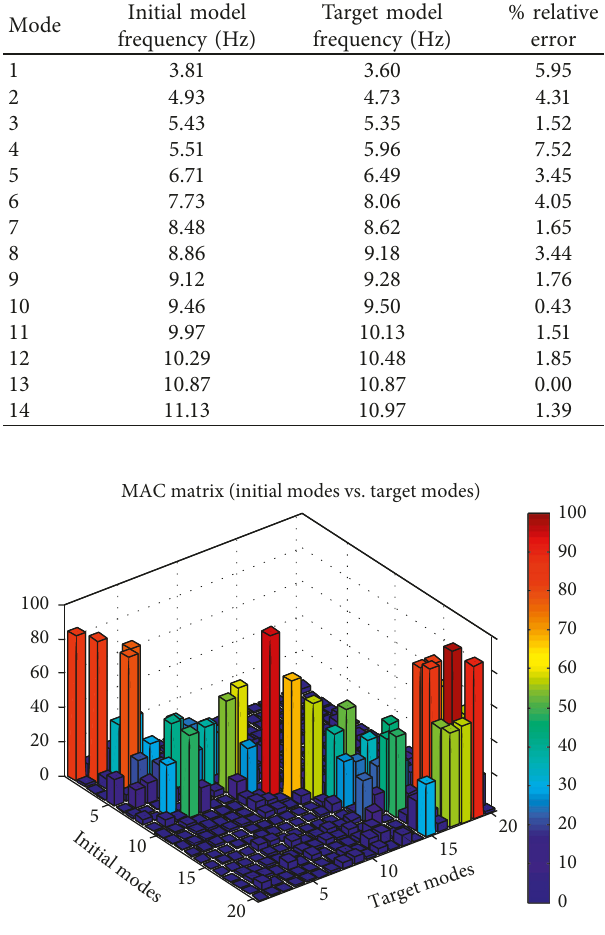
Figure 21: Mode shape for configuration 1 vs. configuration 5.